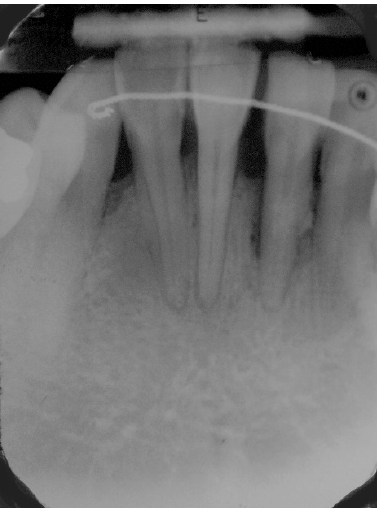
Figure 1. Pre-operative radiograph of lower anterior area showing reduced bone support, with mainly horizontal bone loss.